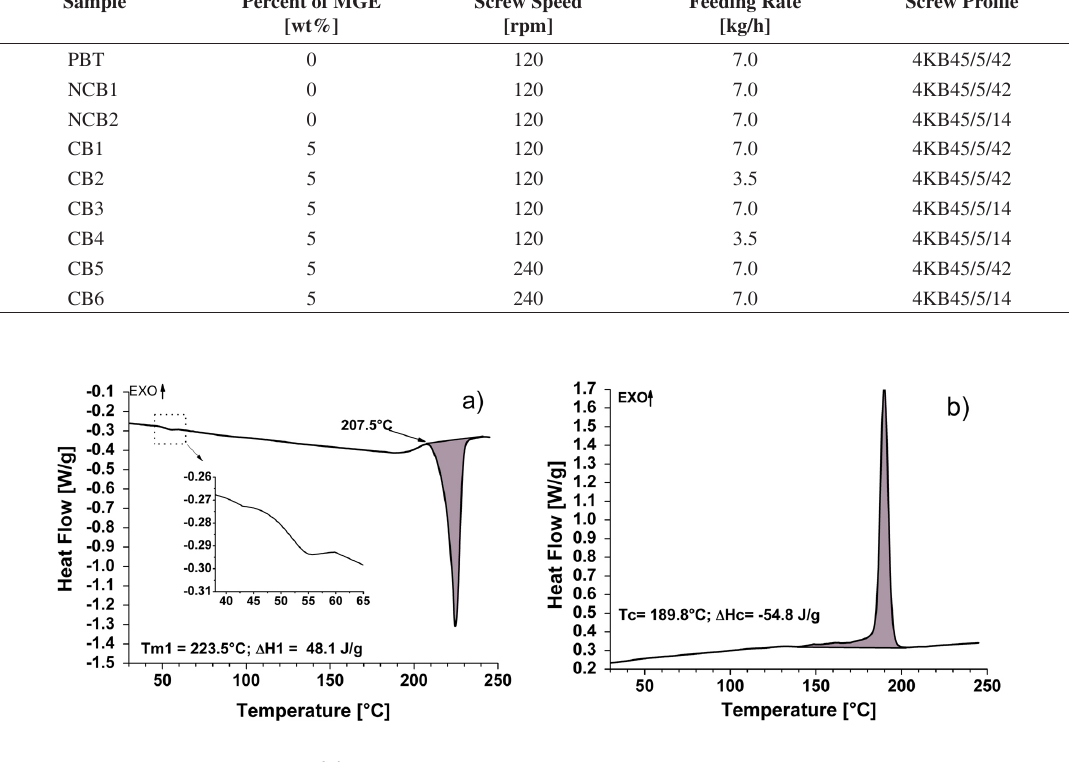
Table 1. Sample identification, compatibilizer content and extrusion processing parameters used to obtain PBT/ABS blends. Sample